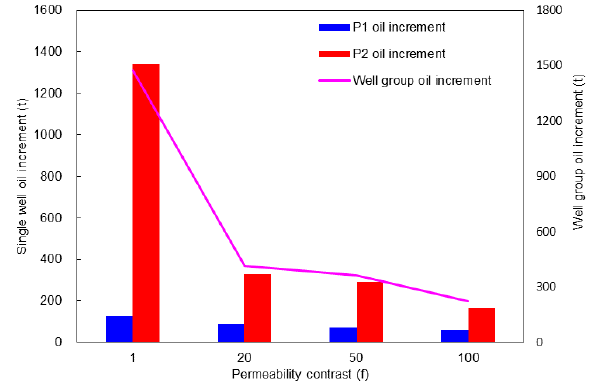
Figure 23. Oil increment with different permeability contrasts.